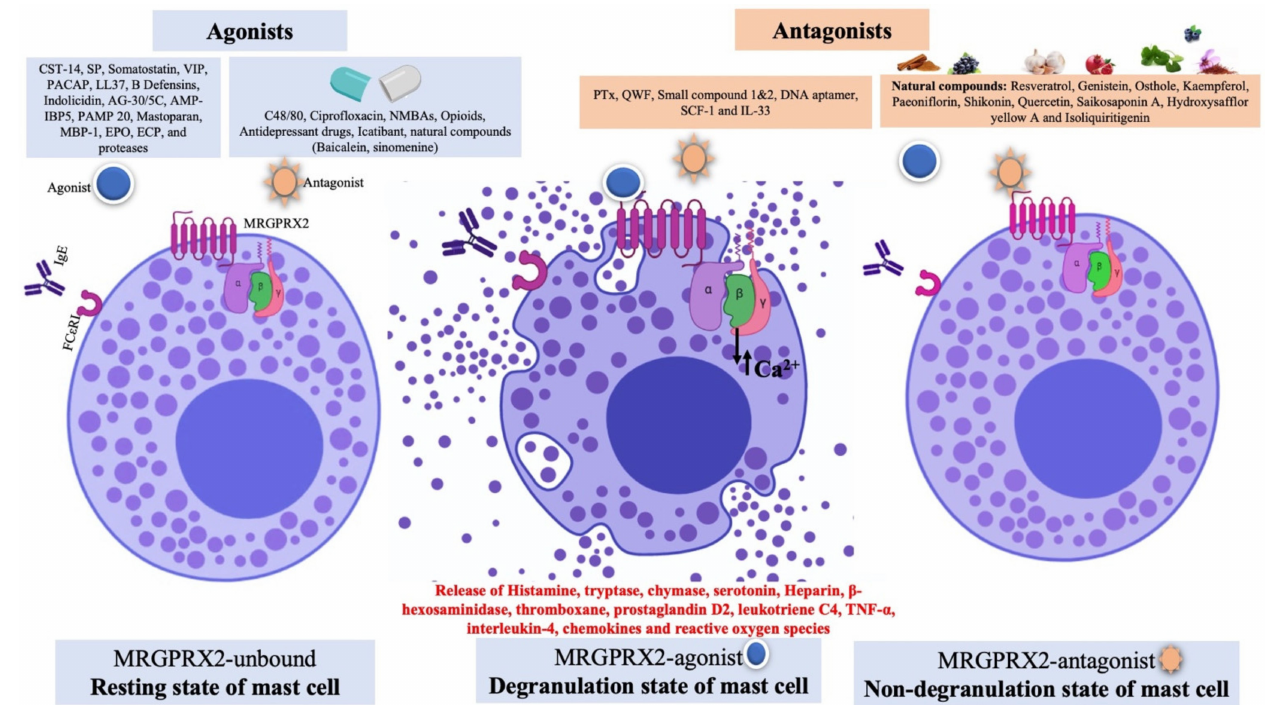
Figure 1. Schematic diagram showing mast cells receptors (Fc ε RI and MRGPRX2), MRGPRX2 ligands (agonist and antagonist) and different states of mast cells. The agonists are broadly divided into peptides and non-peptides (drugs). In an unbound state (where no ligand binds to MRGPRX2), the mast cells are in resting state. For agonists binding to MRGPRX2, the conformational changes in the receptor lead to activation of the G protein and downstream signaling pathway. This state is known as the degranulation state; the activated MRGPRX2 leads to exocytosis, MC degranulation and release of vasoactive and inflammatory mediators. However, the binding of antagonist to MRGPRX2 prevented receptor activation and inhibited MC degranulation and release of inflammatory mediators, which is known as the non-degranulation